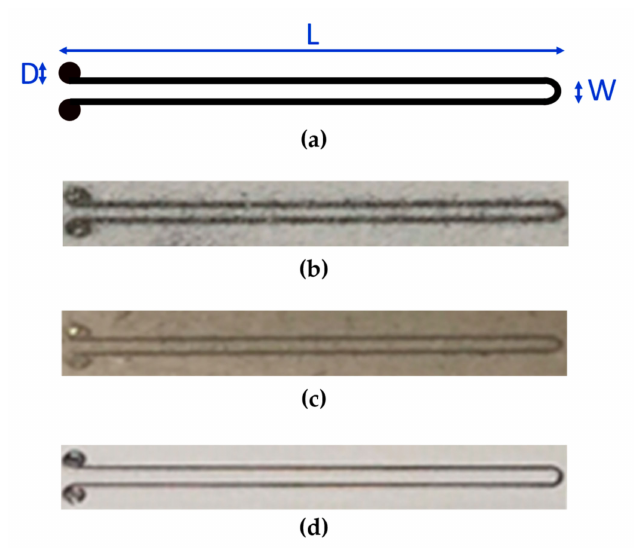
Figure2. ( a )Patternandgeometricaldimensionsofprintedsamples(L = 22.5mm, D = 1mm, W = 1 mm). Image of resulting samples printed on ( b ) chromatographic paper, ( c ) cardboard, and ( d )